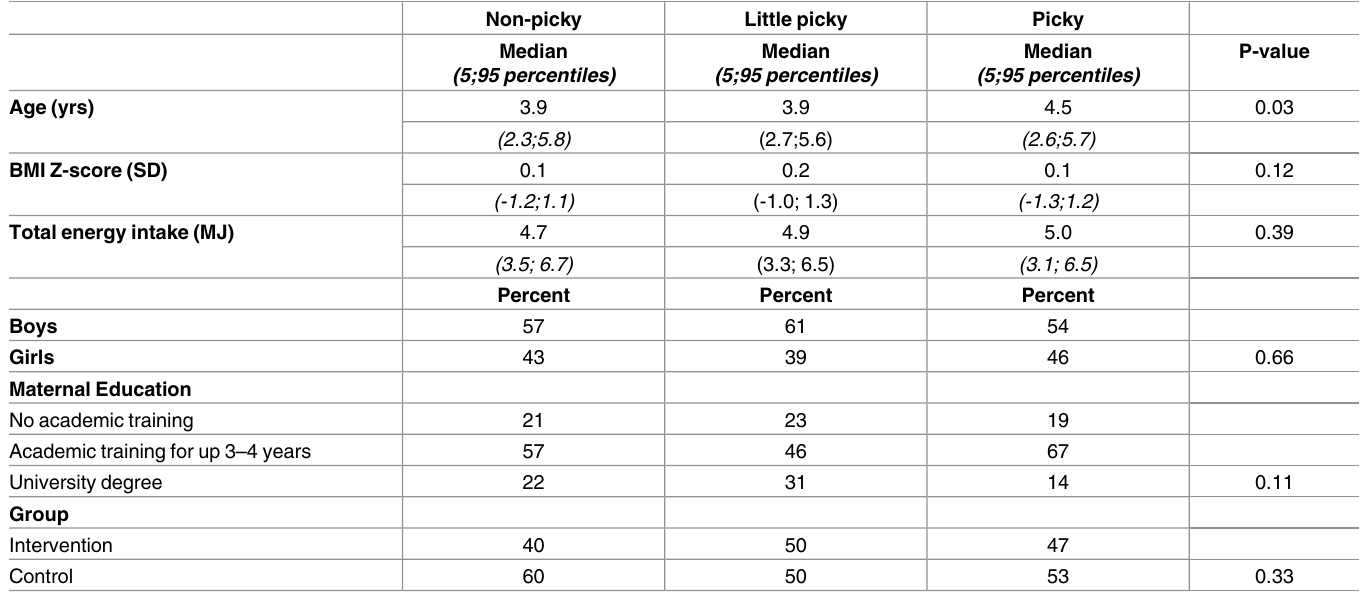
Table 1. Baseline characteristics of the included children stratified by pickiness status. The difference betweengroupswas tested using oneway anovafor continuous variablesand Chi-squared test for categoricalvariables. Results are presented as median(5–95 percentiles) unless otherwisestated 1